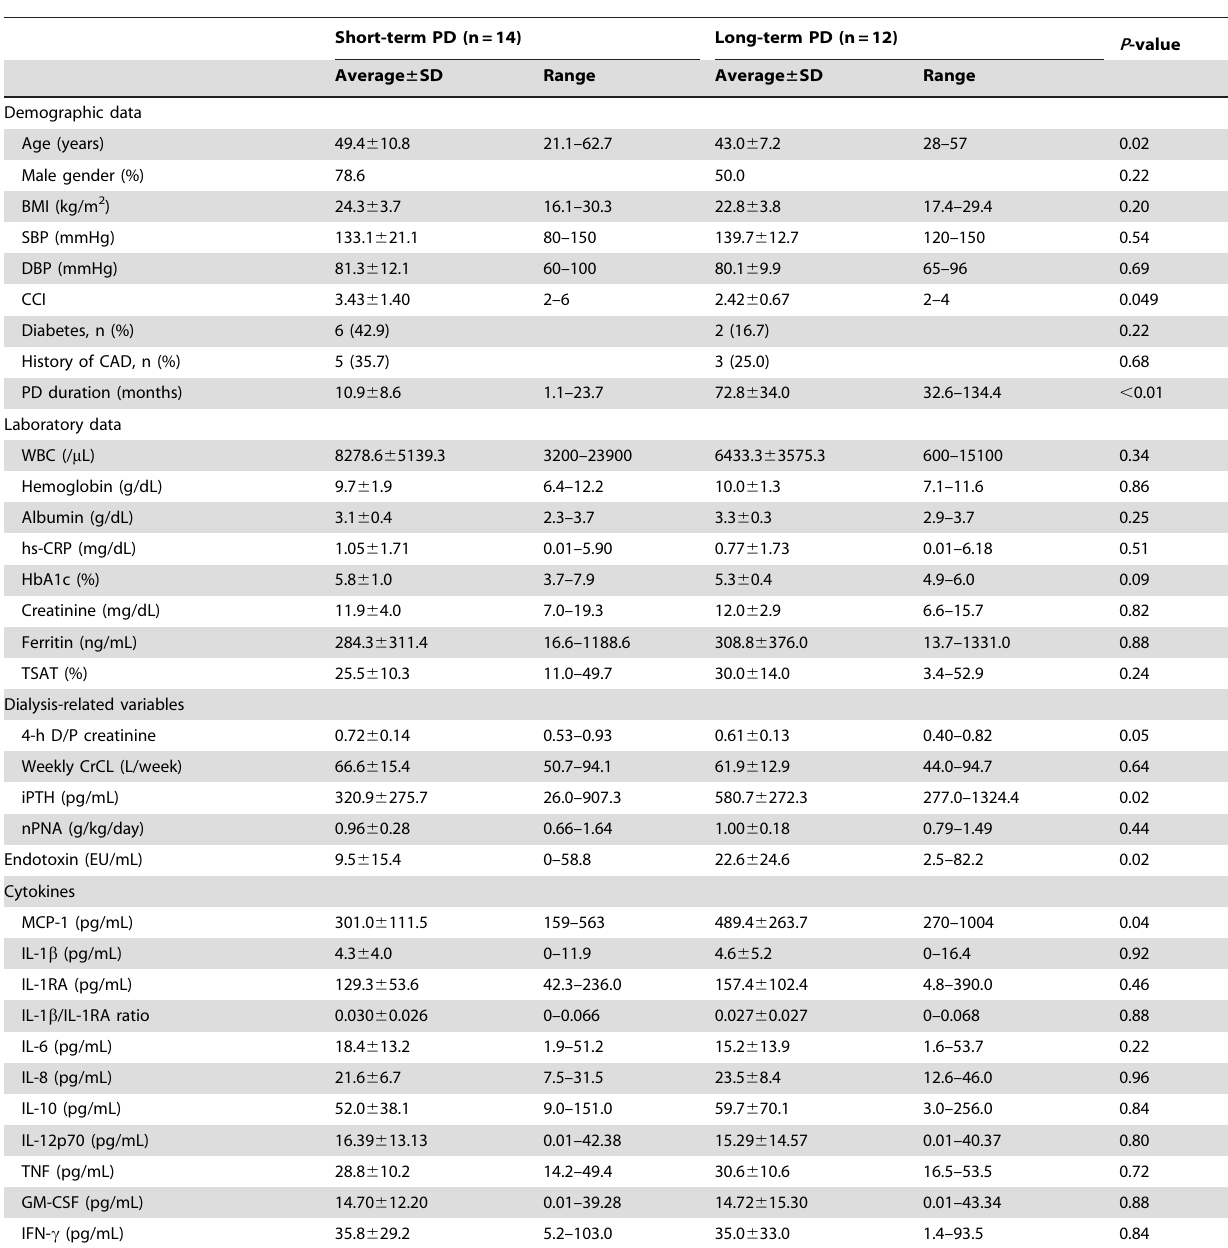
Table 2. Comparison of demographic and laboratory data between the short- and long-term PD